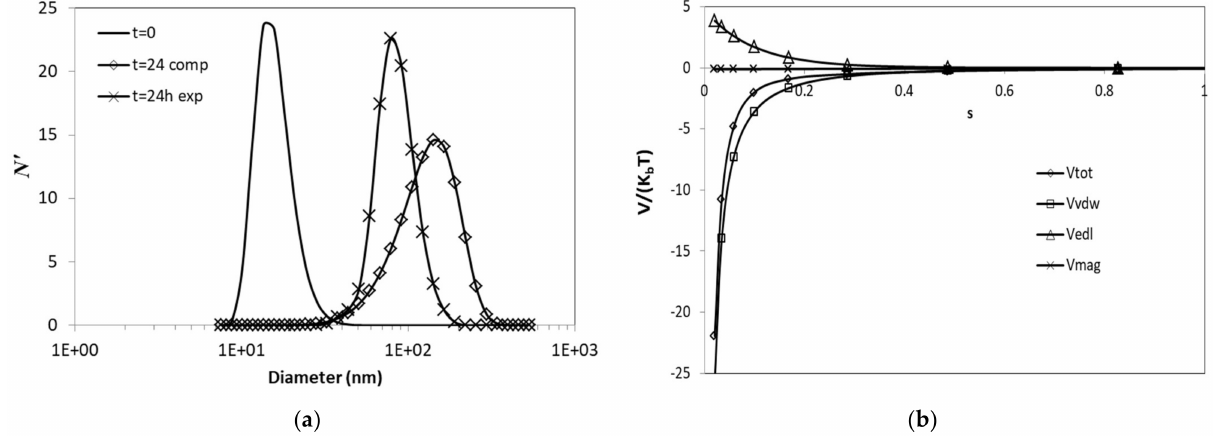
Figure 5. Simulations for a 24 h period ( a ) comparison with experimental results and ( b ) poten- tial energies. Tot—total; vdw—van der Walls; edl—electric double layer; mag—magnetic; comp— computational;